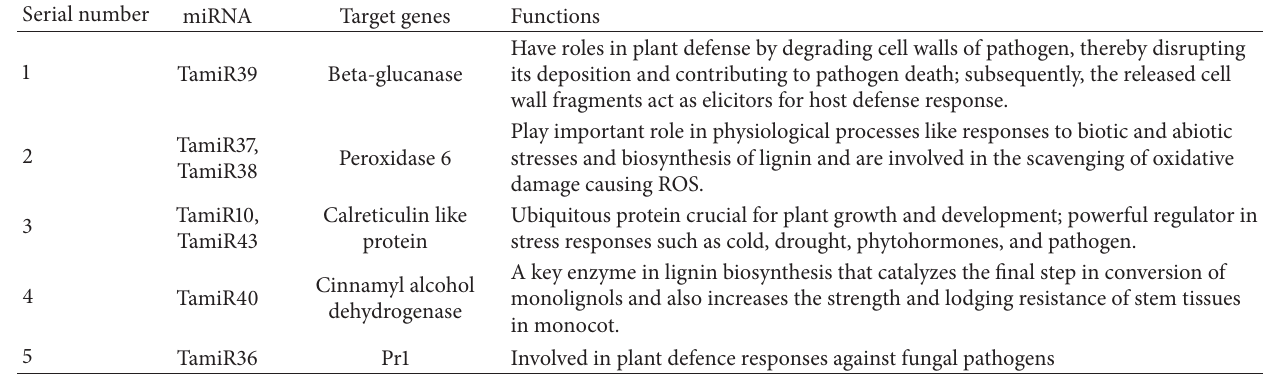
Table 3: Identified miRNAs having targets of pathogen